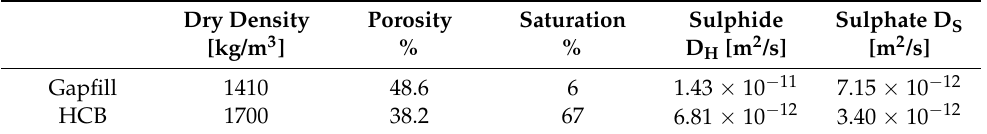
Table 2. Bentonite clay